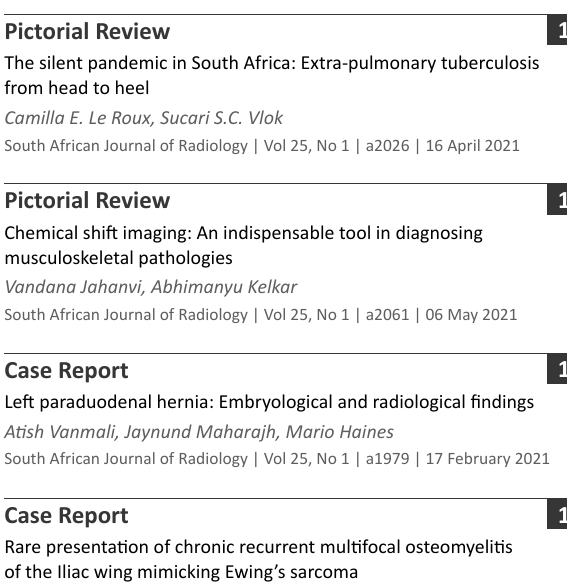
The silent pandemic in South Africa: Extra-pulmonary tuberculosis from head to heel